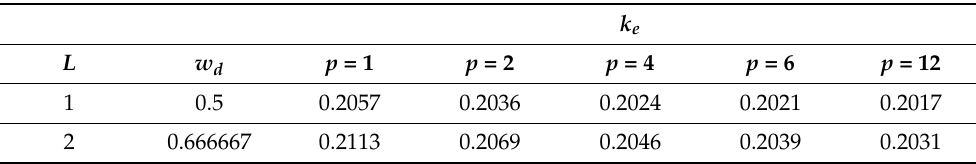
Table 4. Dependence of the equity cost, k e , on leverage level L at different frequency of payments of tax on profit p for three-year company.